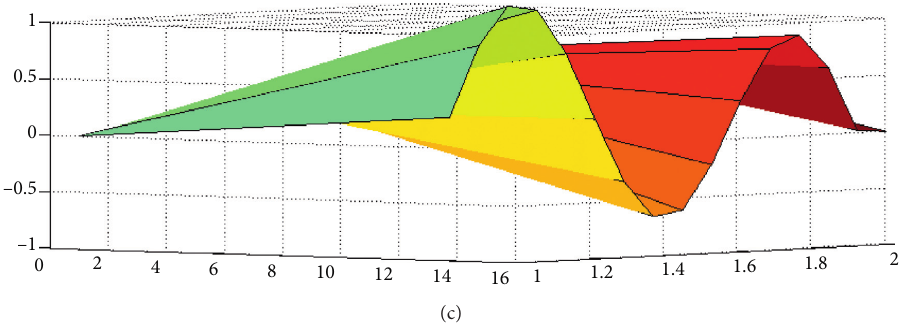
Figure 18: Mode shapes of vibration of symmetric angle-ply conical shell. (a) Mode 1. (b) Mode 2. (c) Mode